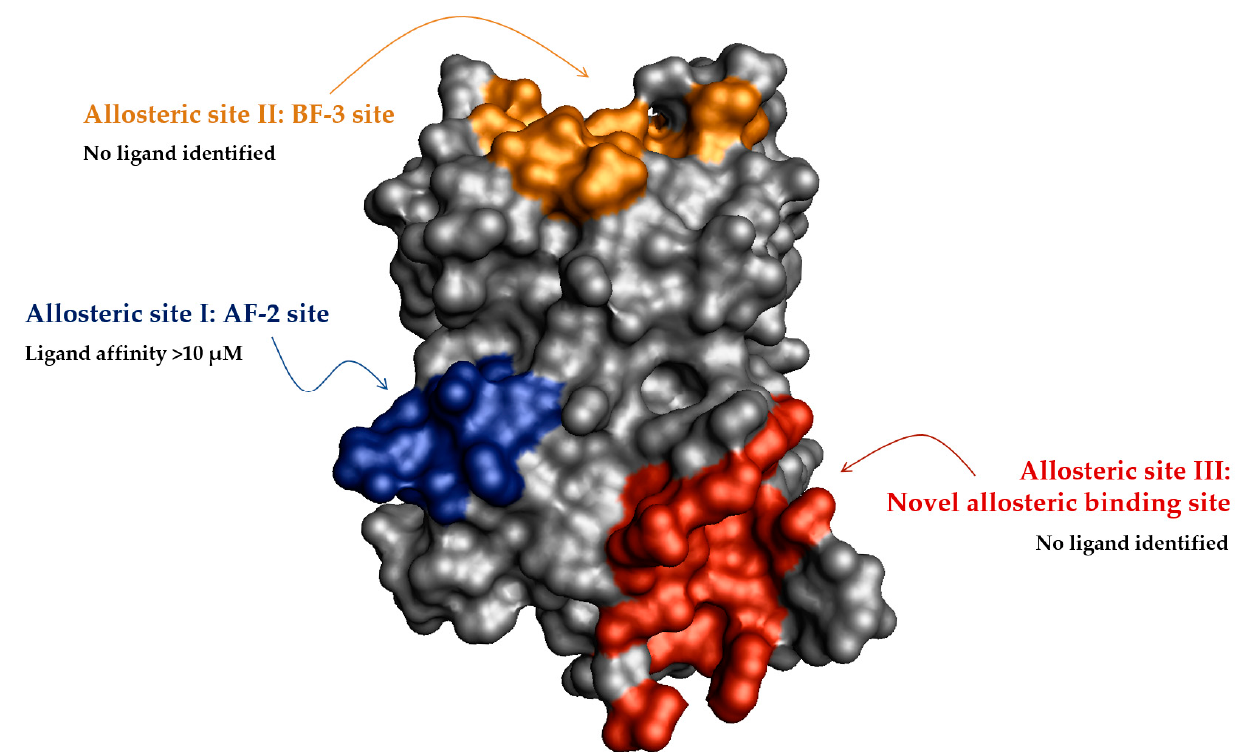
Figure 10. Overview of the surface of the nuclear receptor PXR allosteric sites. Allosteric site I: AF-2 site highlighted in blue; allosteric site II: BF-3 colored orange; allosteric site III in red.